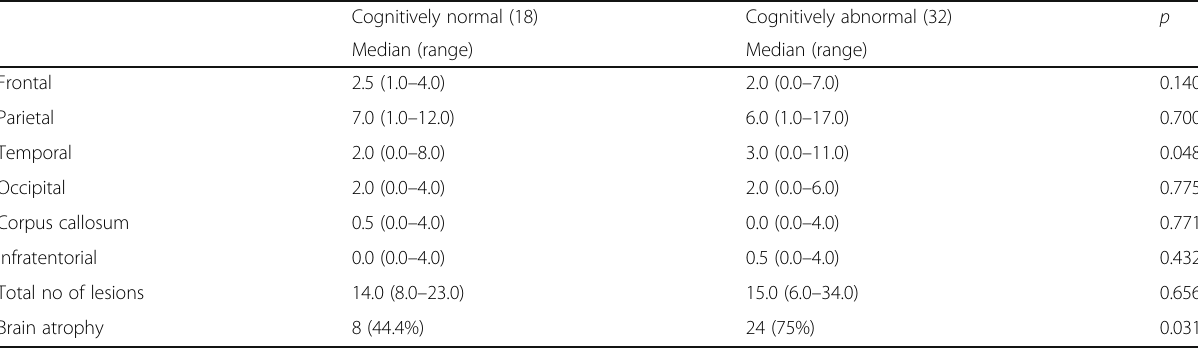
Table 6 Magnetic resonance imaging in cognitively normal and cognitively abnormal